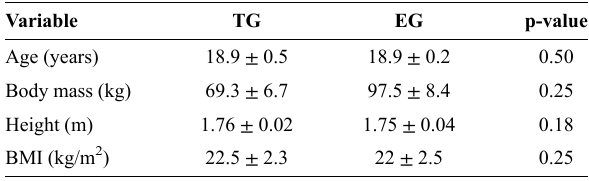
Table 1 - Descriptive characteristics of the